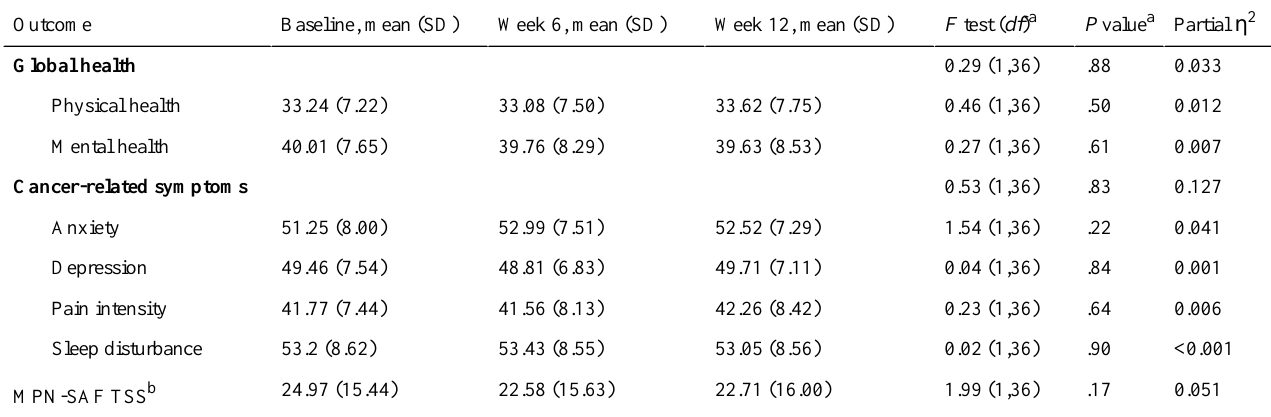
Table 2. Changes in health and cancer-related symptoms during and after the health education podcast intervention